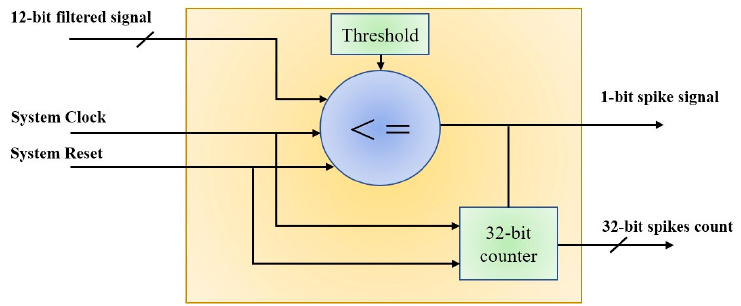
Figure 5. Spike detection module.